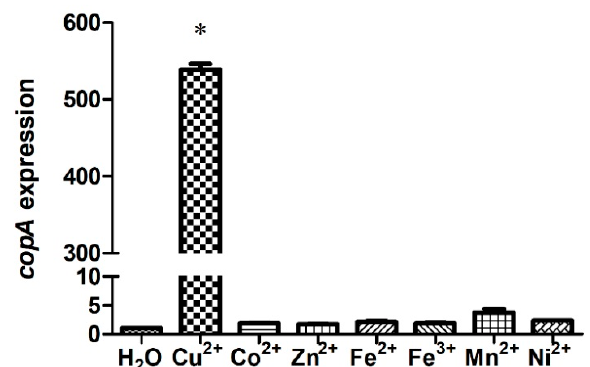
Figure 3. copA expression is up-regulated in response to copper. S. suis was grown in the presence of various metals, and the gene expression levels were calculated using the 2 − ∆∆ C T method with 16S rRNA as the reference gene. Results represent the means and standard deviations (SD) from three biological replicates. * indicates p < 0.05.